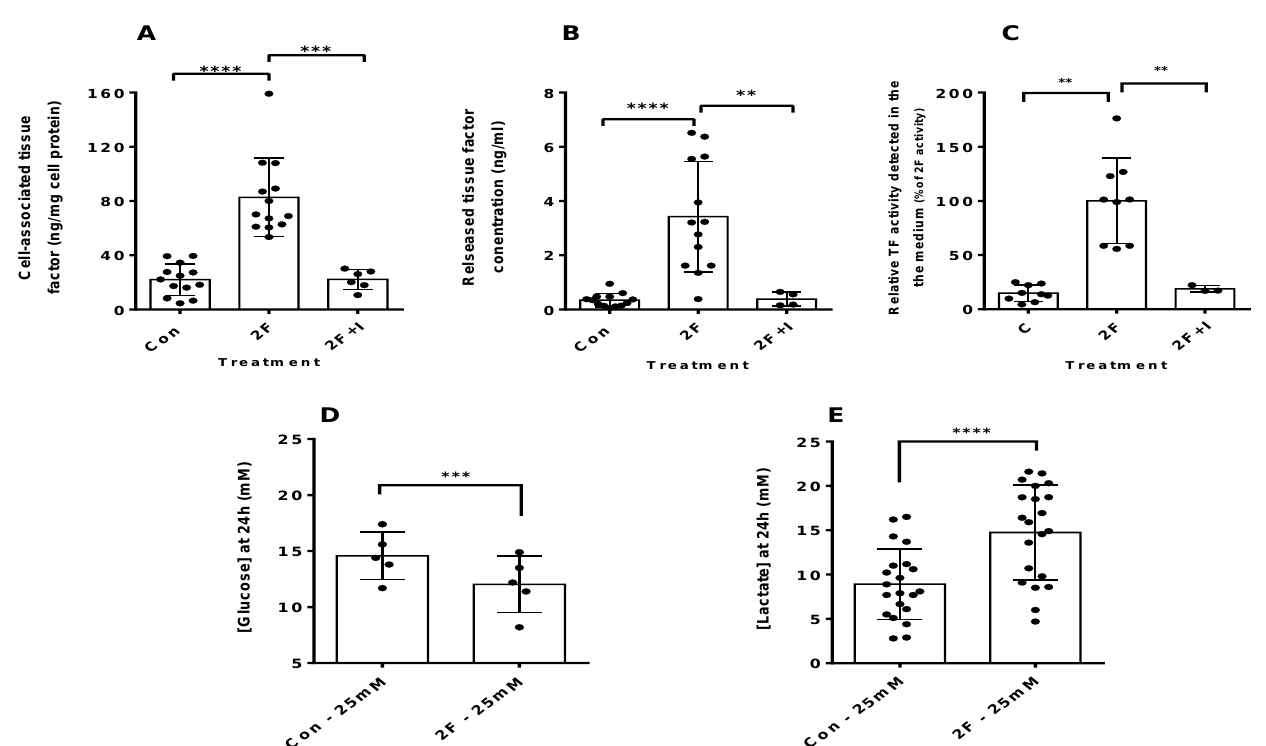
Figure 1. Activation of PAR2 by 2f-LIGRLO-NH 2 (2F) induces tissue factor (TF) synthesis and secretion from HTECs. ( A , B ) Attenuation by a PAR2 antagonist, I-191 (I, 10 µ M). 2F induces enhanced glucose consumption and lactate secretion. ( A , B ) TF-specific ELISA was used to measure the TF concentrations produced by HTECs treated with or without 2F. ( C ) A chromogenic factor Xa activity assay was used to assess the TF activity of conditioned medium (secreted TF). ( D , E ) The final glucose and lactate concentrations of the conditioned medium from control cells and 2F-treated cells. T-tests were used to determine significance of mean differences. Bars represent the mean ± SD. **, *** and **** indicate significance of p < 0.01, p < 0.001 and p < 0.0001, respectively. n ≥ 3 for all treatments. Con = Control, 2F = 2f-LIGRLO-NH 2 (2 µ M), I = I-191 (10 µM).